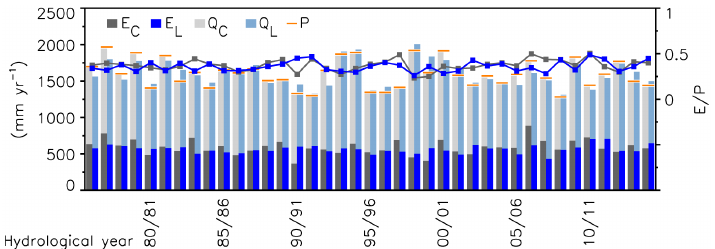
Figure 3. Catchment water balance for the hydrological years (i.e., October–September) 1976/1977 until 2014/2015. E C denotes catchment evapotranspiration, E L lysimeter evapotranspiration, Q C catchment runoff, Q L lysimeter seepage, and P precipitation (corrected according to Gurtz et al. (2003), Table 1 therein). The lines show the ratio E C /P (dark gray) respectively E L /P